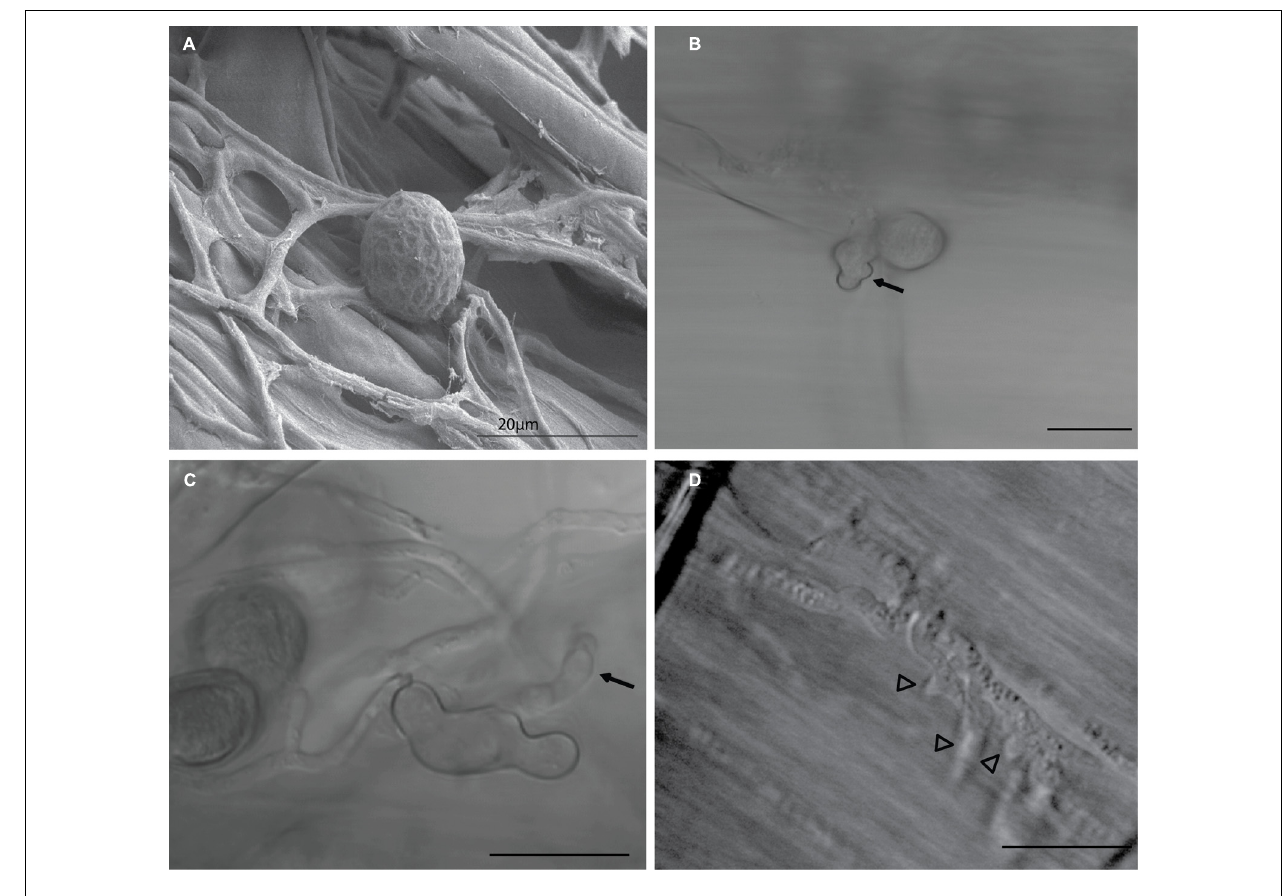
may share similar functions to haustoria and arbuscules formed by pathogenic and mycorrhizal fungi, respectively, suggesting possible roles in acquisition of nutrients and secretion of effectors into host tissue. Image (A) was taken using scanning electron microscope (SEM), Images (B–D) were taken using a light microscope. Bars =20 μ